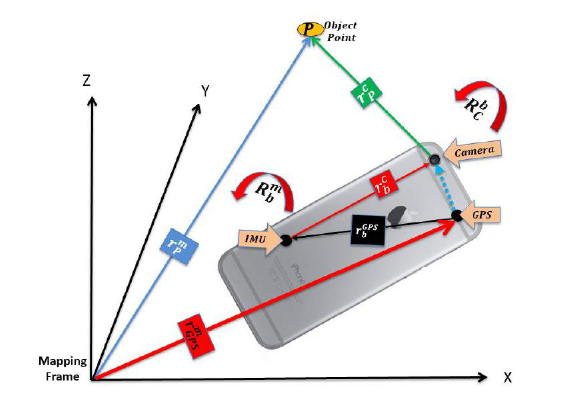
Figure 1. Position of the object point with respect to the mapping system